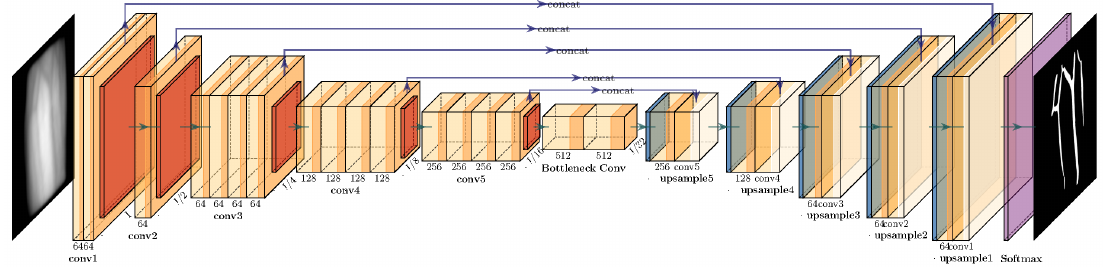
Figure 5. U-Net for vein segmentation. Orange layer is convolution layer, red is max-pooling, blue is upconvolution and purple is